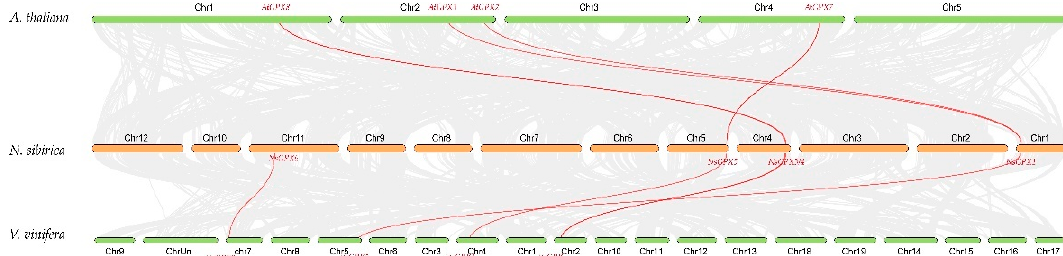
Figure 3. Synteny analyses of GPX genes in N. sibirica , A. thaliana , and V. vinifera chromosomes. Background gray lines represent the collinear blocks within the genomes of N. sibirica and other plants, meanwhile the red lines highlight the syntenic GPX gene pairs.